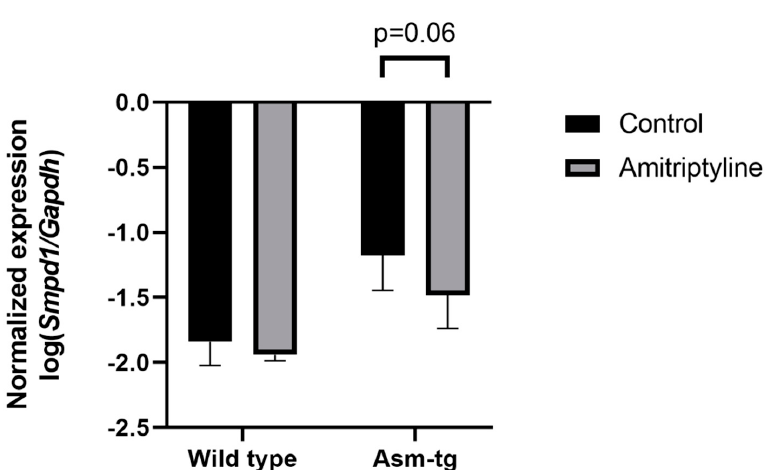
Figure 2. Smpd1 mRNA expression is decreased in dorsal hippocampal brain tissue of Asm-tg mice after antidepressant treatment . After a daily treatment with amitriptyline for four weeks, Smpd1 mRNA expression was decreased in Asm-tg mice as compared with controls. N = 5. Data represent the mean and SD.